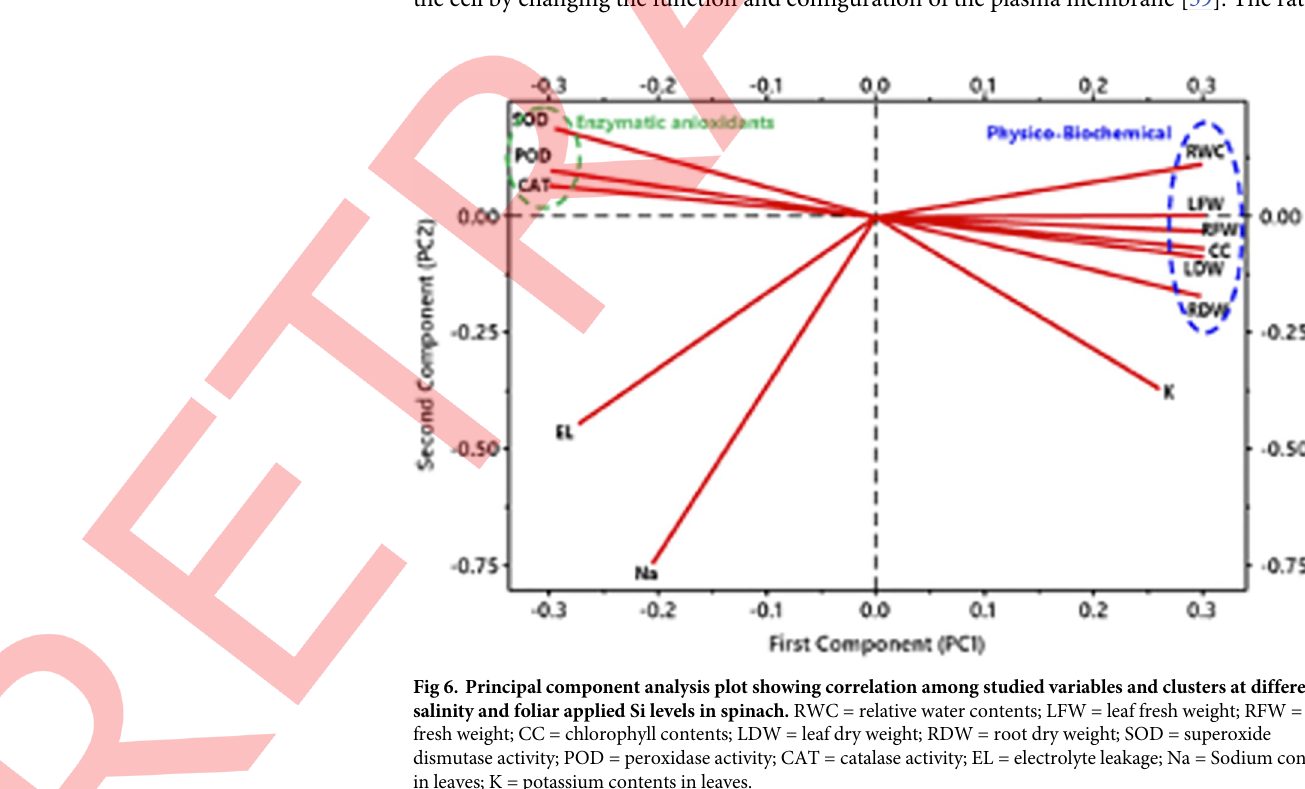
Fig 6. Principal component analysis plot showing correlation among studied variables and clusters at different salinity and foliar applied Si levels in spinach. RWC = relative water contents; LFW = leaf fresh weight; RFW = root fresh weight; CC = chlorophyll contents; LDW = leaf dry weight; RDW = root dry weight; SOD = superoxide dismutase activity; POD = peroxidase activity; CAT = catalase activity; EL = electrolyte leakage; Na = Sodium contents in leaves; K = potassium contents in